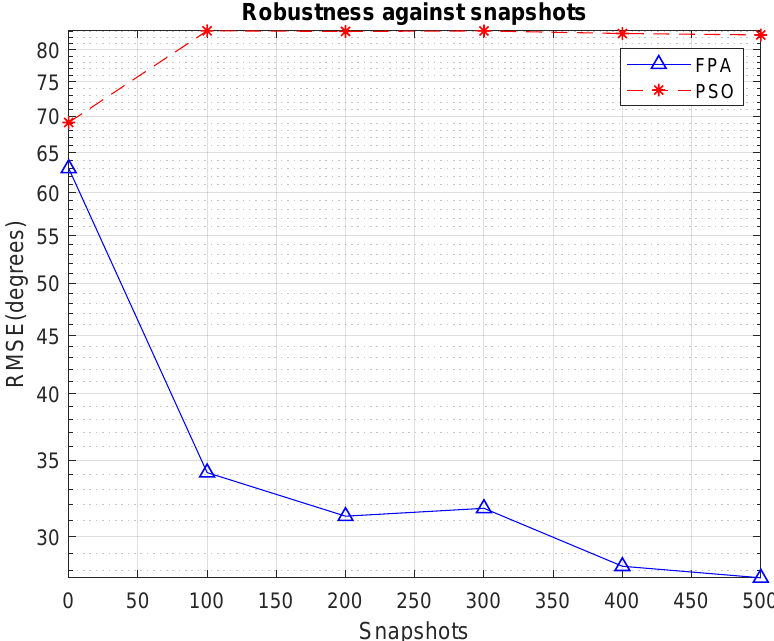
Figure 8. Robustness against snapshots for nine